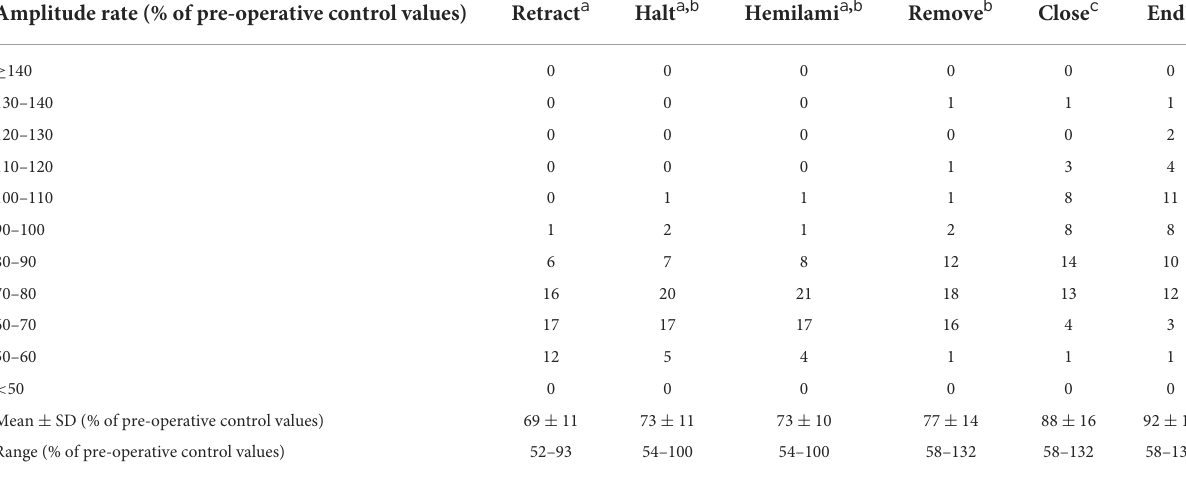
TABLE 1 Number of dogs in each range of amplitude rate of six surgical procedures. Amplitude rate (% of pre-operative control values)